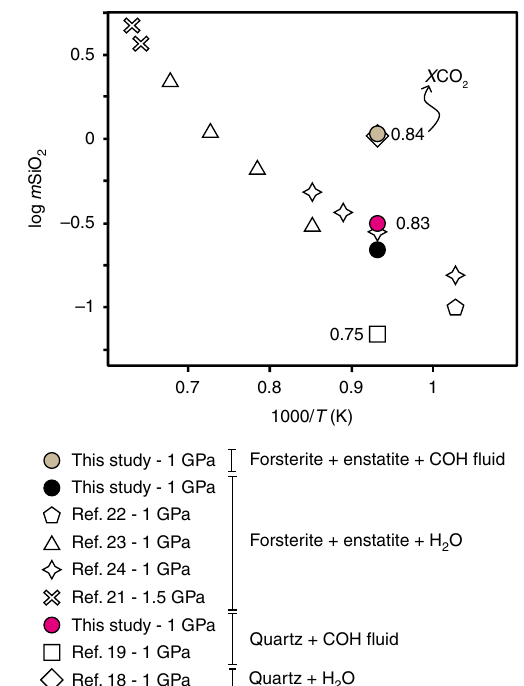
Fig. 2 Measured dissolved SiO 2 in graphite-saturated fl uids interacting with silicates. Solute contents in experimental fl uids at P = 1 GPa, T = 800 °C and f H 2 NNO in equilibrium with graphite + forsterite + enstatite (MgO – SiO 2 – COH system; ochre dot ), and with graphite + quartz (SiO 2 – COH system; pink dot ), expressed as moles of SiO 2 per kg of water, measured by cryogenic laser-ablation ICP-MS. Solute content of forsterite + enstatite in pure water ( black dot ) and selected literature solubility data in the systems SiO 2 – H 2 O, SiO 2 – COH and MgO – SiO 2 – H 2 O are shown for comparison. The measured dissolved silica is 0.22 mol kgH 2 O − 1 in